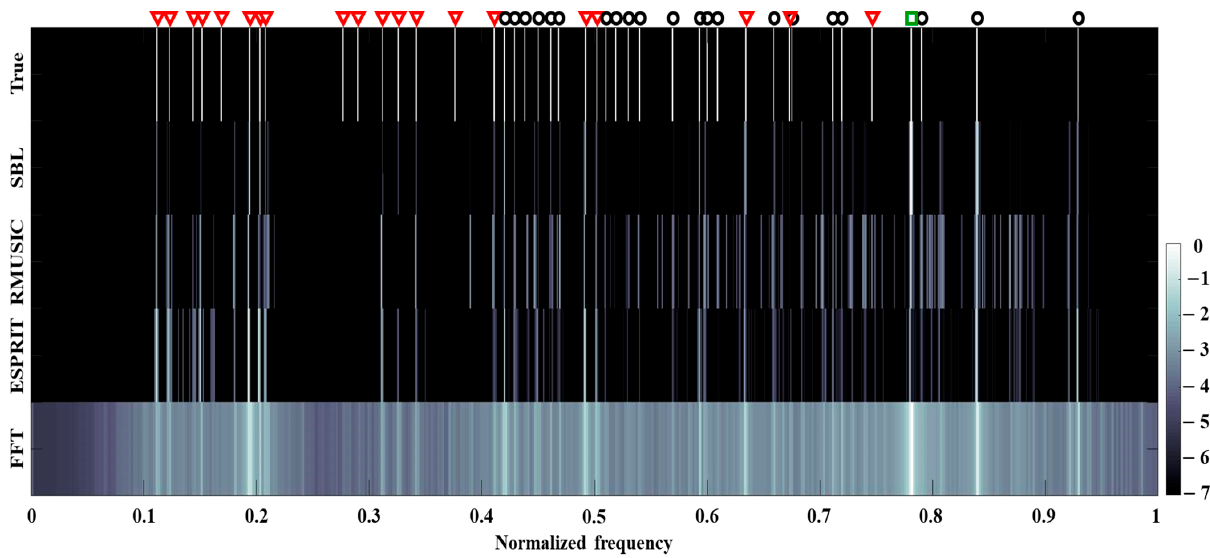
Figure 7. Averaged frequency detection results of Figure 6 over time according to SBL, RMUSIC, ESPRIT, and FFT. Blurs in FFT and false detections in RMUSIC and ESPRIT are mitigated by the SBL owing to its sparse estimation.